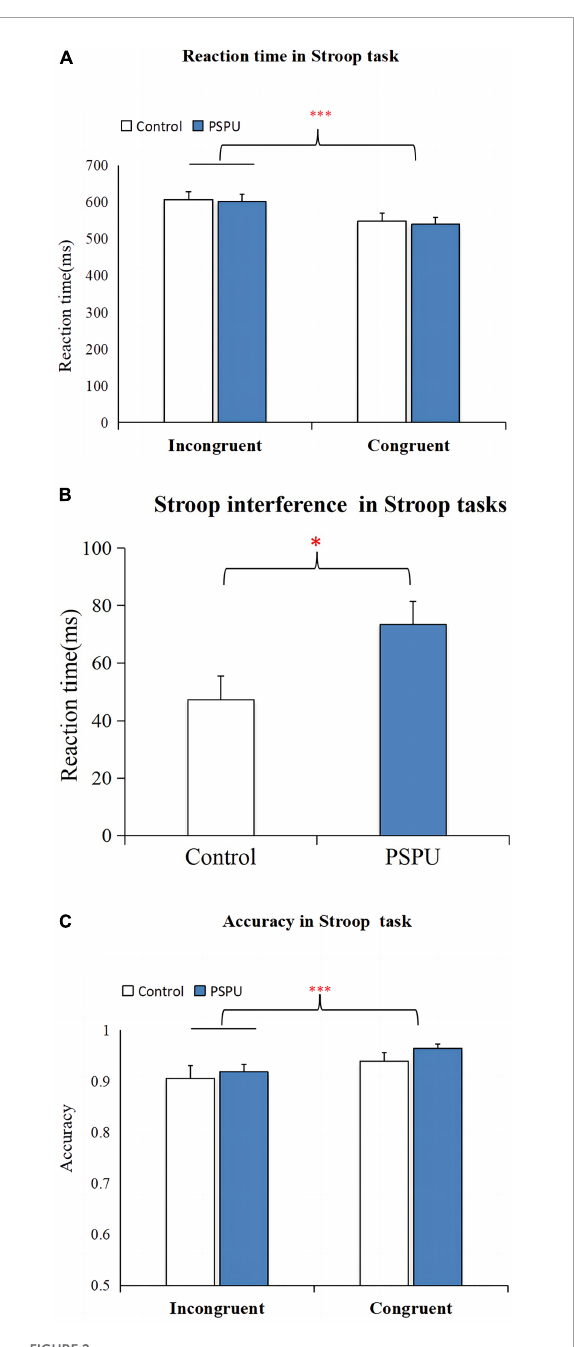
FIGURE2 Stroop task performance. (A) Comparison of RT between congruent and incongruent task. (B) Comparison of Stroop interference on RT between the control and PSPU groups. (C) Comparison of AC between congruent and incongruent task. All data are expressed as the mean ± standard error. ∗∗∗ p ≤ 0.001.